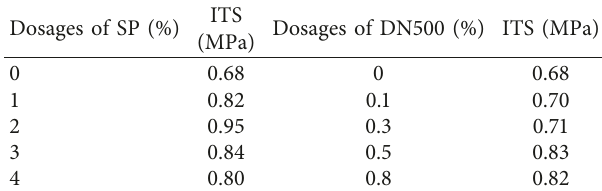
Table 4: Effect of individual addition of different dosages of superplasticizer and DN500 on the ITS of